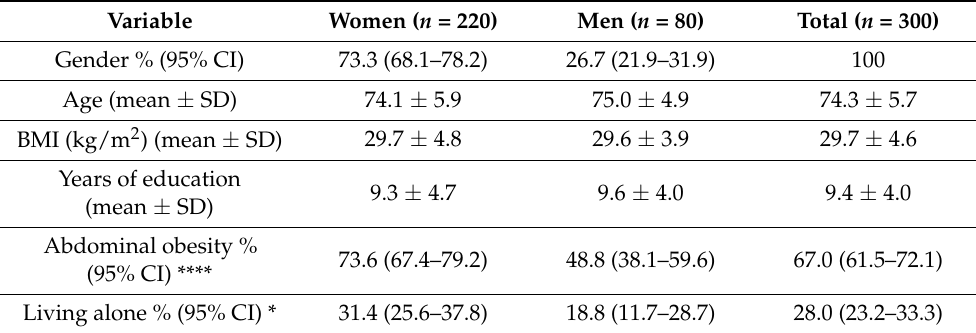
Table 1. Characteristics of the studied